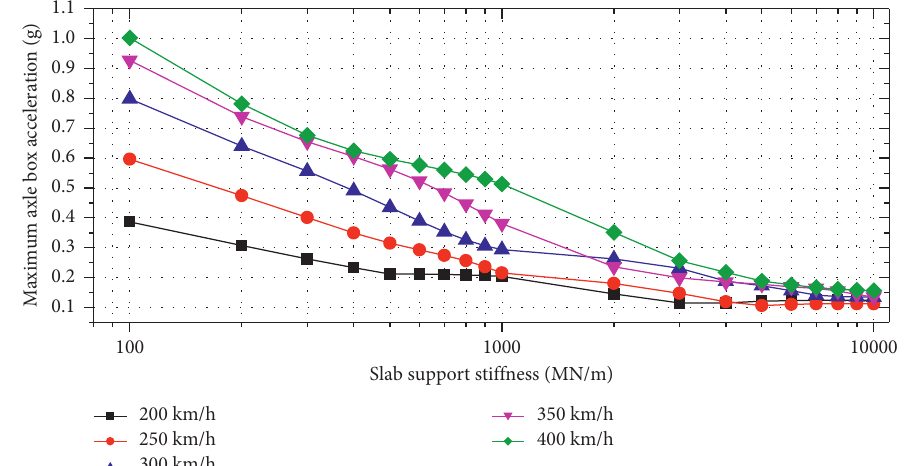
Figure 18: Effects of slab support stiffness and vehicle speed on the slab passing-induced axle box